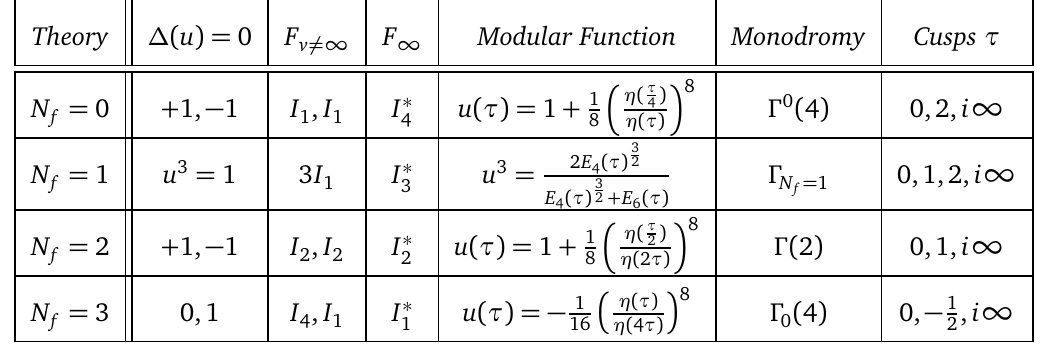
< 3 flavours. Note that the f